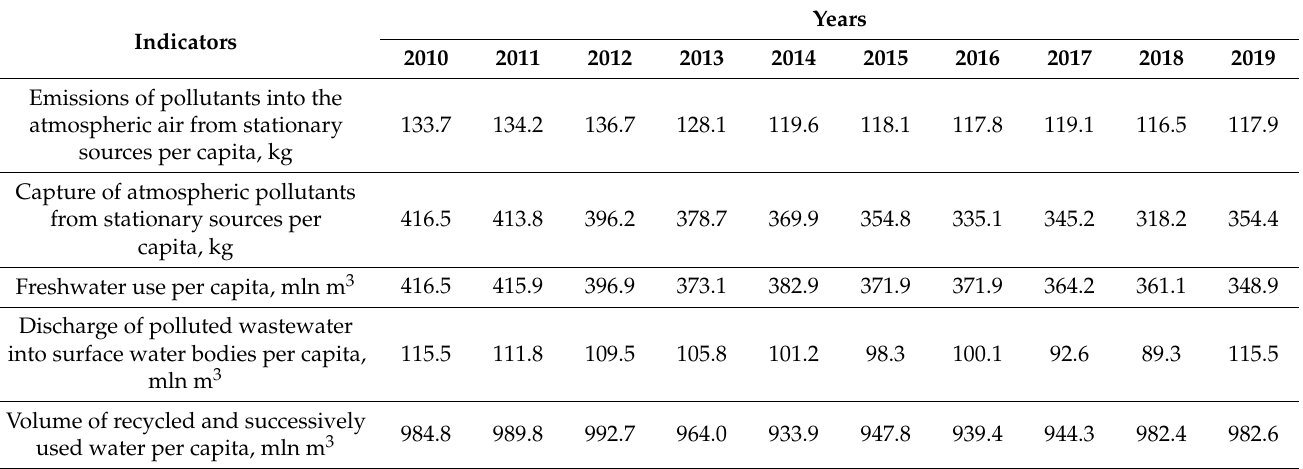
Table 7. Main indicators characterizing the macro-regional block “Ecology” in the Russian Federation in